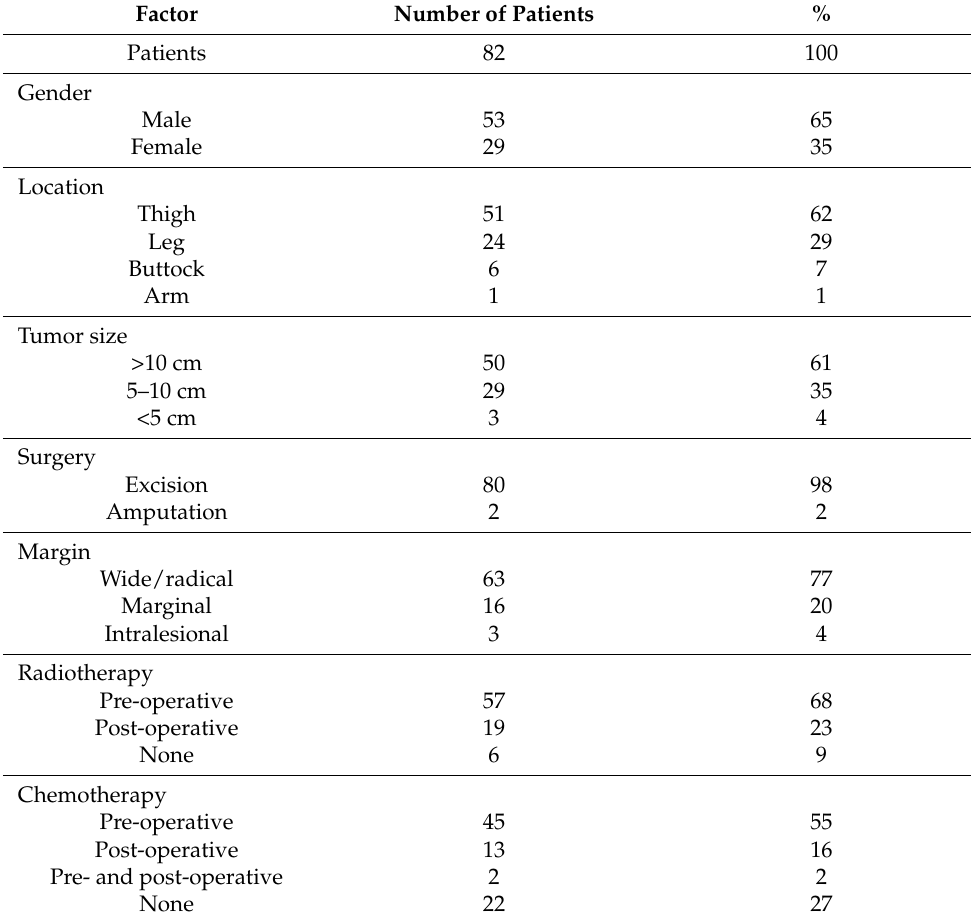
Table 1. Main clinicopathological features and therapeutic approaches.